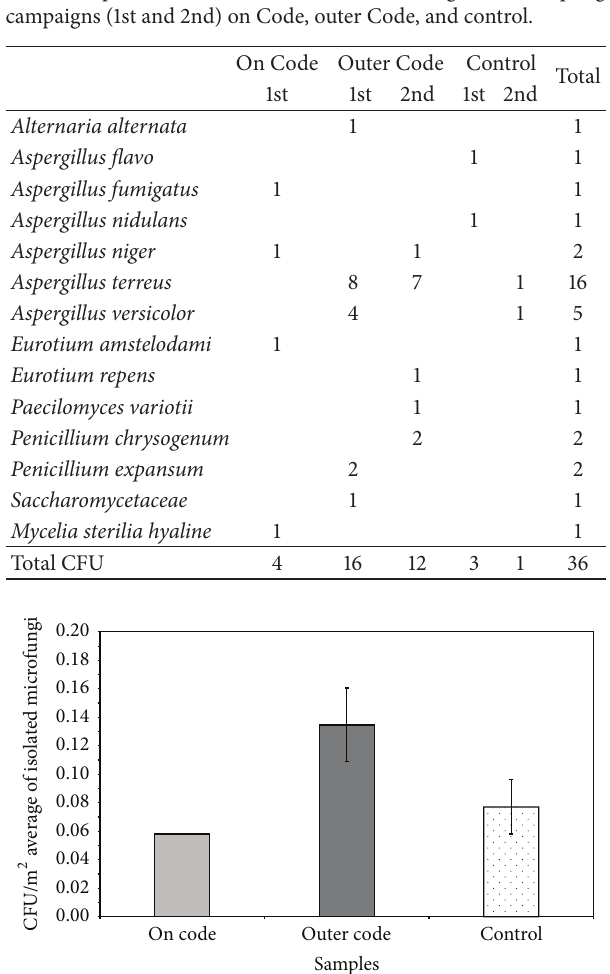
Figure 2: CFU/m 2 average of microfungi isolated from the two sampling campaigns, on Code, outer Code, and